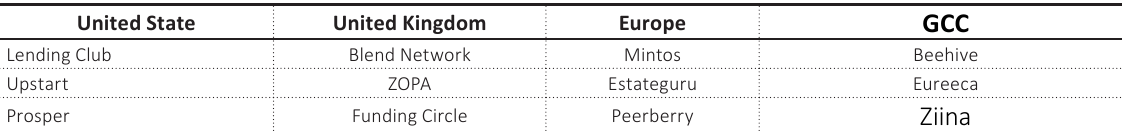
Table 3. Incentives of free trade zones and investment parks